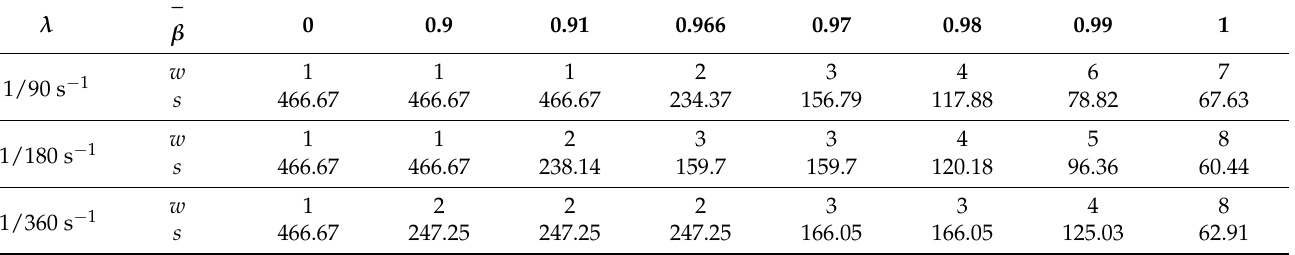
Table 2. Optimum values of w and s for λ = 1/90 s − 1 , λ = 1/180 s − 1 , and λ = 1/360 s − 1 α = 0.9, AoI α = 420 s, varying β .